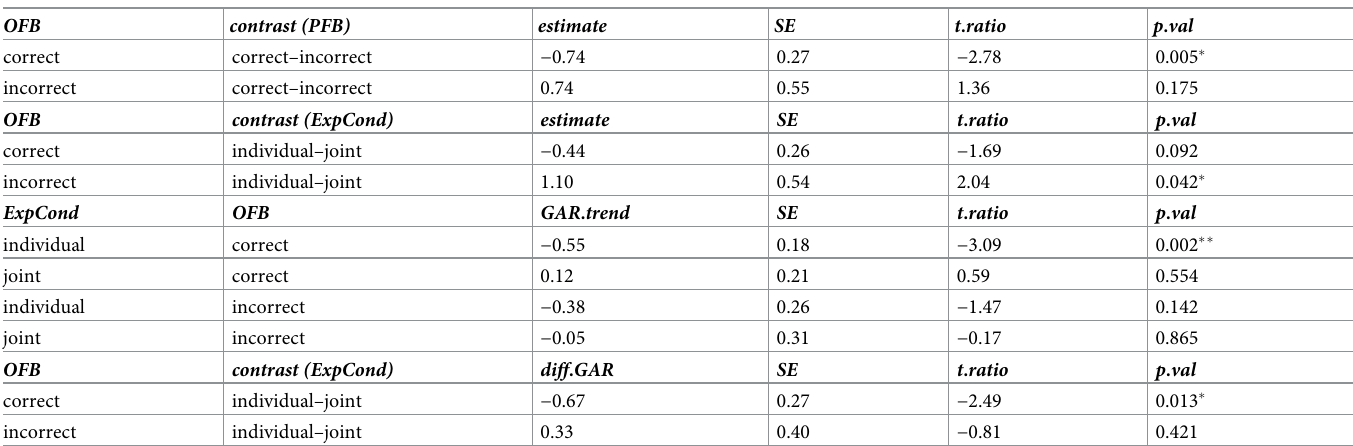
Table 4. Summaries of post-hoc test for FRN/RewP.